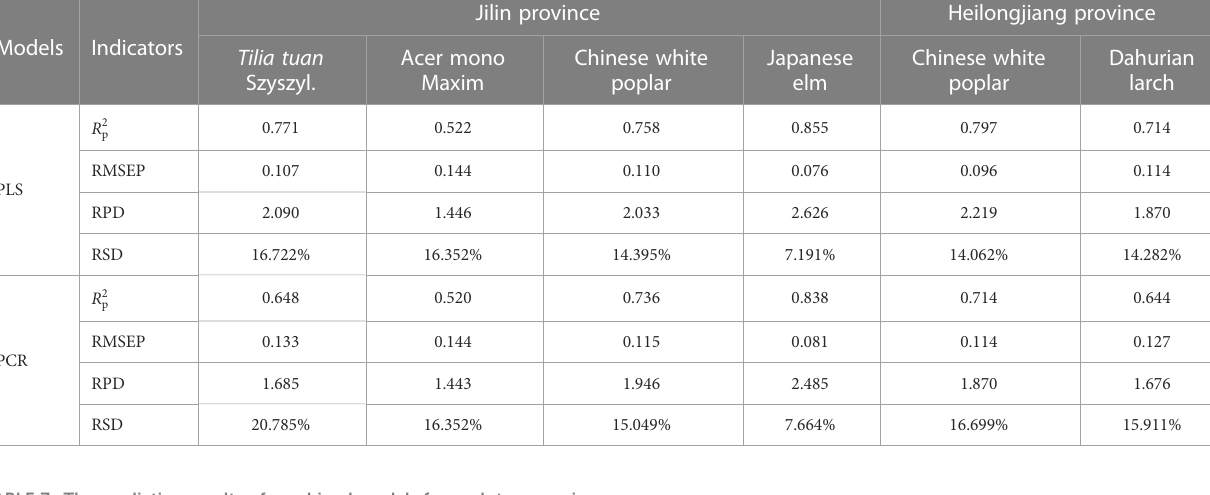
TABLE 7 The prediction results of combined models for each tree species.